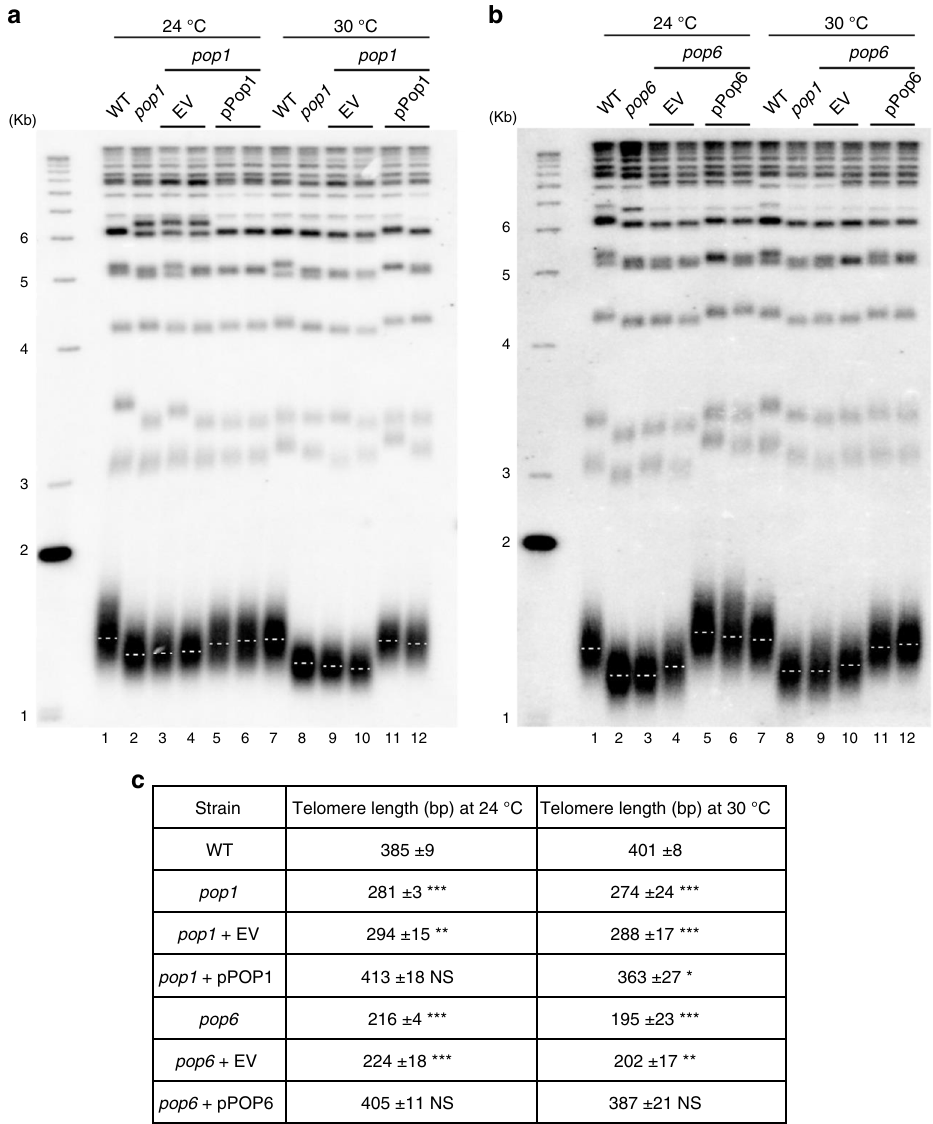
Fig. 3 pop1 and pop6 cells have short telomeres at 24 and 30 °C that is reversed by introducing a WT copy of POP1 or POP6 . DNA was isolated from the indicated strains, digested with XhoI, and analyzed by Southern blotting using a radio-labeled TG 1-3 probe. Cells were grown at 24 or 30 °C for ~75 generations prior to DNA extraction. a, b EV, empty vector; p POP1 or p POP6 , the same vector containing POP1 or POP6 . Dotted white lines mark the average telomere length in each sample. c Quantitation of telomere lengths in at least three biological isolates of each strain. Size of telomeric tracts were determined by subtracting 875 nts of Y ’ DNA from the sizes of the terminal XhoI fragments. Introducing a WT copy of the POP gene reversed telomere shortening in pop1 and pop6 cells. P-values were calculated using unpaired two-tailed Student ’ s t -test; * P ≤ 0.05 , **P ≤ 0.01, *** P ≤ 0.001, **** P ≤ 0.0001; NS, not signi fi cant, P >0.05. Asterisks indicate signi fi cance of telomere length differences in pop cells versus